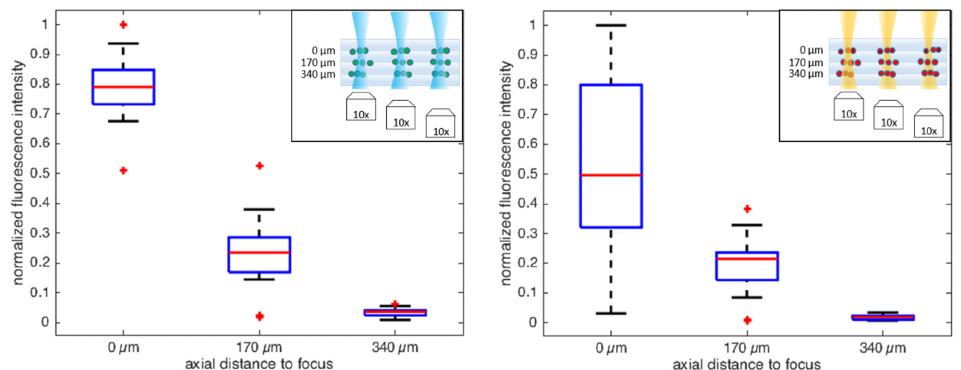
Figure 6. Intensity distribution of fluorescent particles over depth in a three-layer sample. Left : Nile Red particles illuminated with 488 nm. Right : Purple particles illuminated with 589 nm. Insets show the mode of measurement: The focus of the illuminating beam is always on the first layer, while the observation assesses fluorescent particle intensities in different layers.